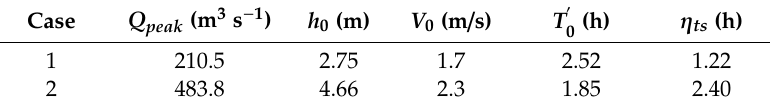
Table 7. The hydraulic characteristics of the upstream inflow.